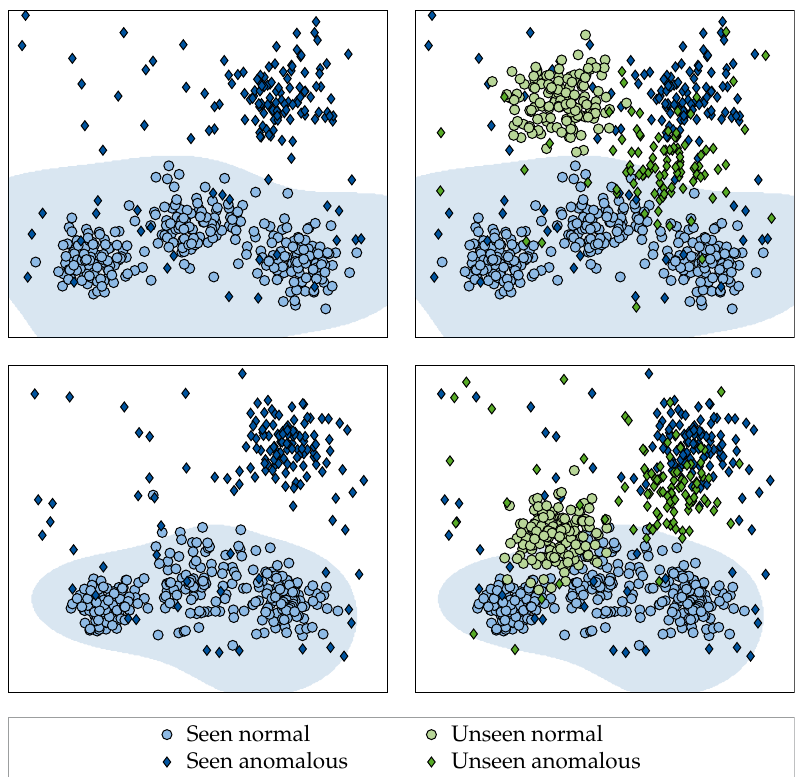
Figure 1. Toy problem demonstrating different ways generalization can manifest itself in multi- fabric AD. While both the poorly generalizing model (top left) and the better generalizing model (bottom left) achieve similar performance on the fabrics they were trained on, the performance on fabrics unseen during training may differ significantly. Comparing the two models, it becomes clear that the better generalizing model has a tighter clustering of normal data (and, correspondingly, a tighter decision boundary), a larger distance between anomalous and normal data clusters and maps the clusters of the unseen fabrics closer to their corresponding seen counterparts (i.e., anomalous to anomalous and normal to